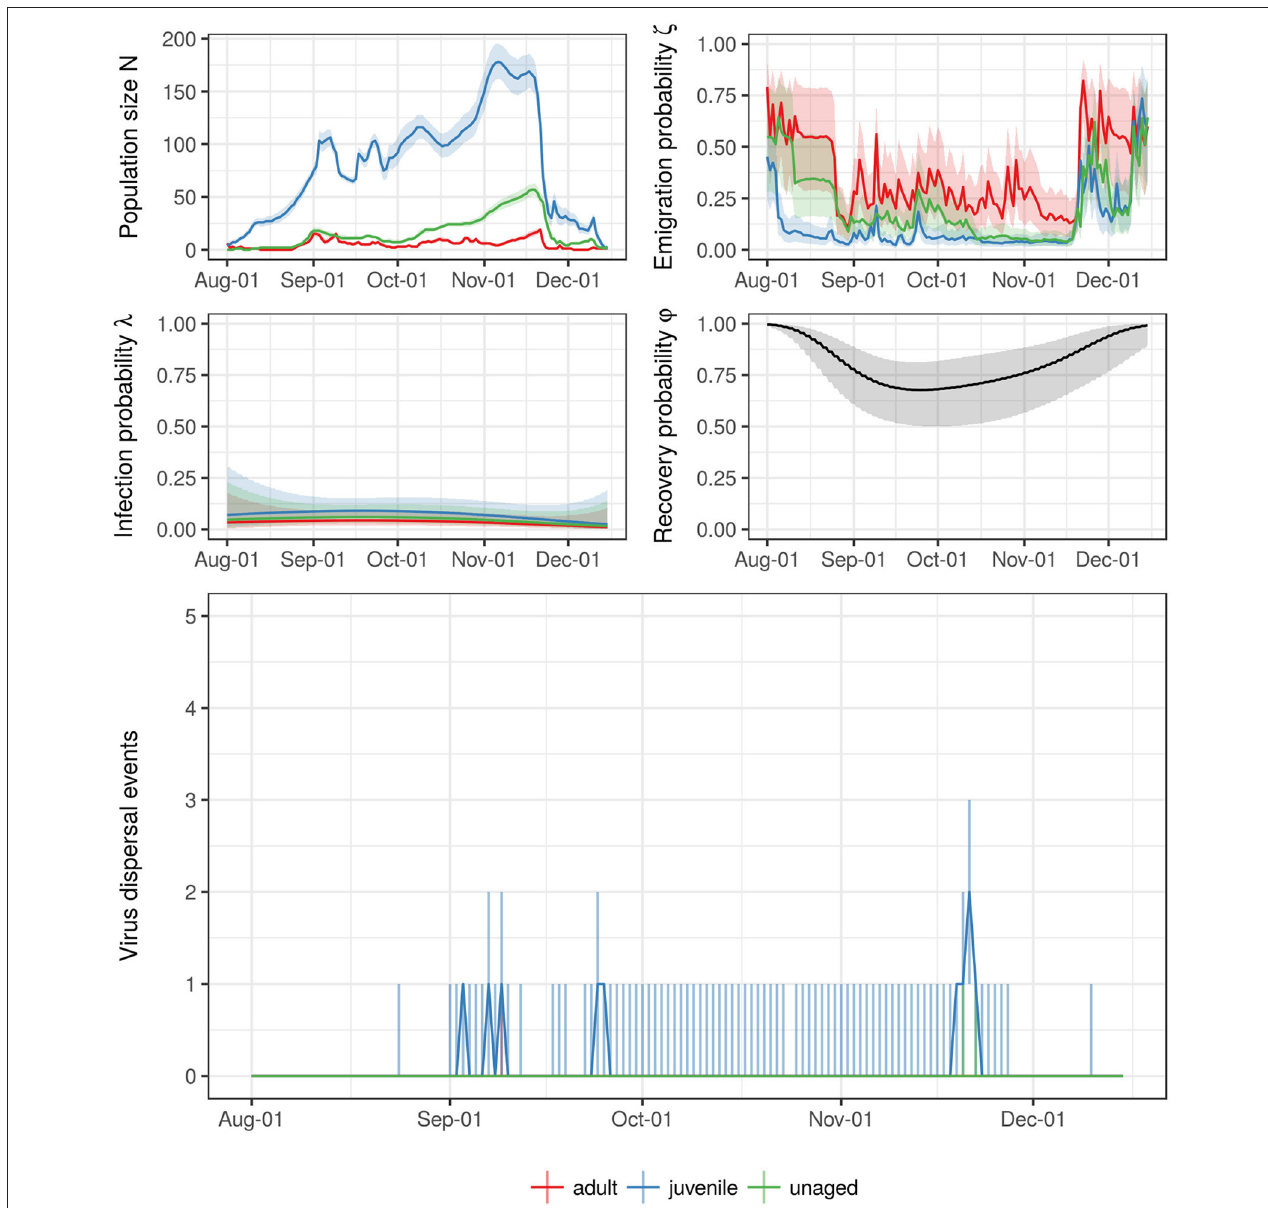
FIGURE 6 | Summary for the entire trapping season of 2004. The top four figures show the estimates for the size of staging population ( N ) as well as the corresponding emigration, infection, and recovery probabilities ( ζ , λ , and ϕ , respectively) thoughout the trapping season. The different colors correspond to the different age classes (but notice that recovery probability ϕ did not differ between age classes). The line represents the median (mean for ζ and ϕ ) estimate and pointwise 95% confidence intervals. The bottom figure shows the estimate for the number of dispersal events throughout the trapping seasons. The line shows the median, the line range delineates the 25- and 75%